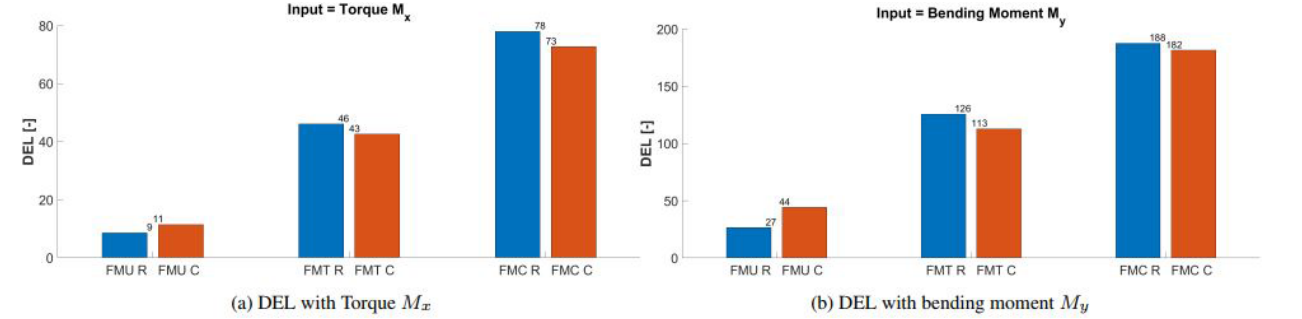
Figure 13. Normalized DEL calculation comparison between rigid (blue) and coupled (red) for the cases FMU, FMT and FMC.